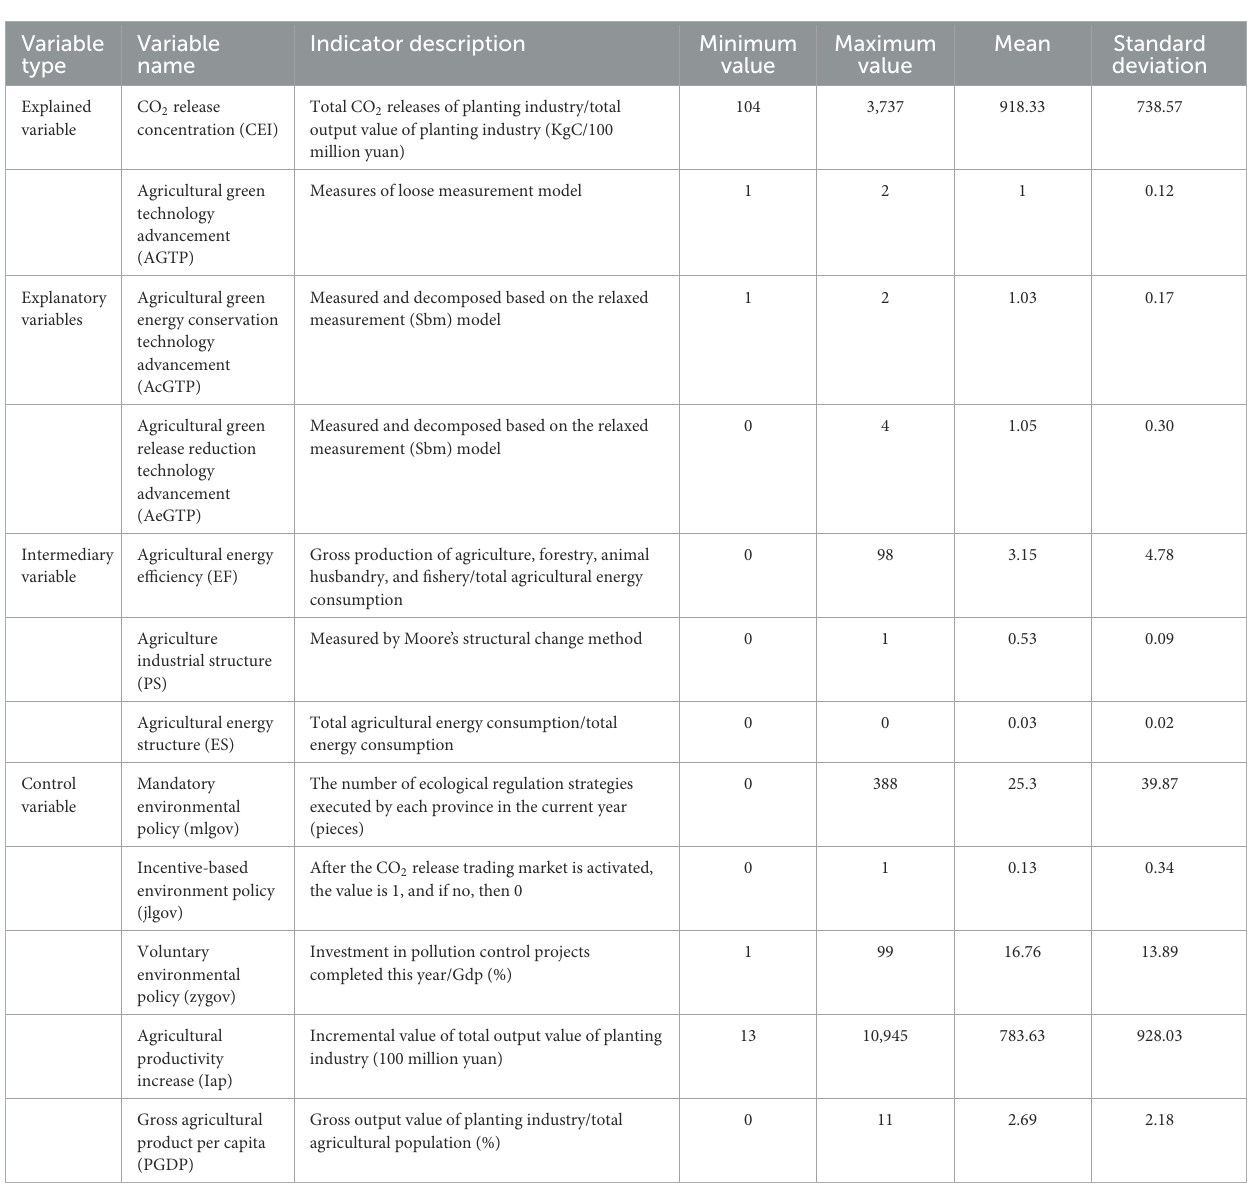
TABLE 1 Descriptive statistics of